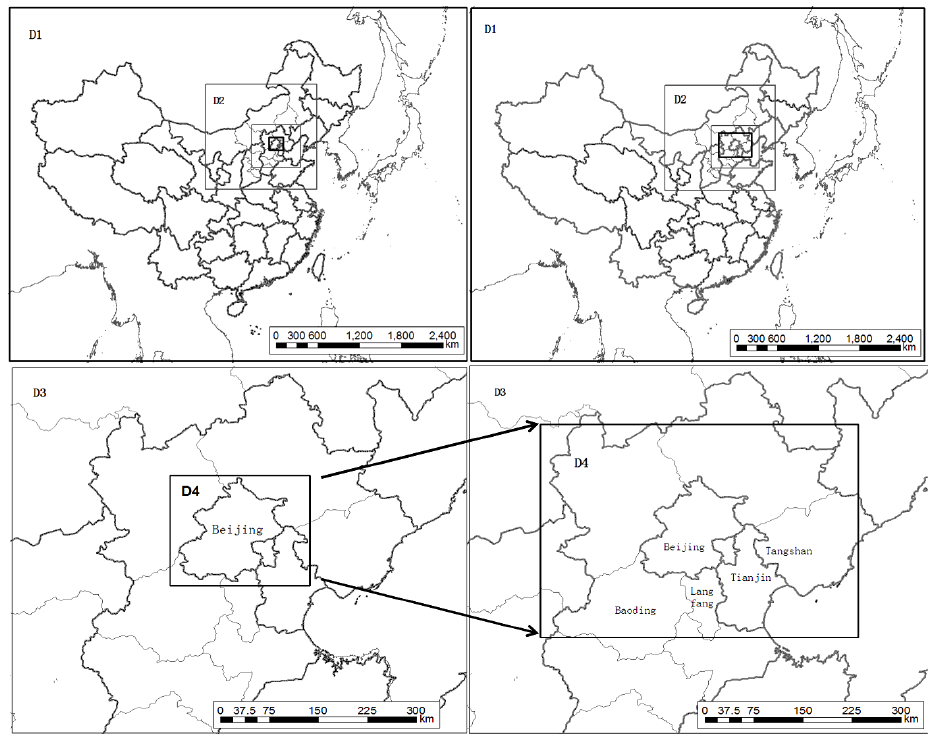
Figure 2. The four-nest domain used in the forecast system and the “new” enhanced domain in the hindcast. Left, the forecast system: D1 covers East Asia with 81km horizontal resolution and 83 × 65 grids. D2 includes North China as shown in the upper panel. D3 consists of Beijing, Tianjin and most of Heibei province, but D4 only covers Beijing Municipality with 73 × 64 grids of 3km resolution as shown in the lower left panel. On the right, the domain for the “new” simulation (hindcast) in this study – we enlarge the inner D4 domain with 160 × 124 grids of 3km resolution, to cover Beijing and its surrounding municipal cities, including Tianjin, Baoding, Langfang and